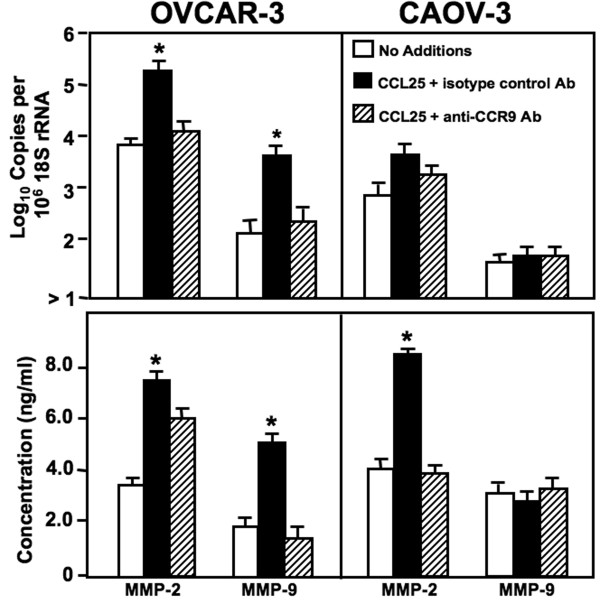
CCL25-induced gelatinase expression by ovarian cancer cells. Cells were tested for their ability to express gelatinases (MMP-2 and MMP-9) mRNA and protein. OVCAR-3 and CAOV-3 cells were cultured for 24 hours alone, with 100 ng/mL of CCL25, or 100 ng/mL of CCL25 + 1 μg/mL of monoclonal antibodies against CCR9. Total RNA was isolated and quantitative RT-PCR analysis was performed for mRNA expression of gelatinases (upper panel) and transcript copies are presented relative to actual copies of 18 S rRNA. Active gelatinases in conditioned media were quantified by Fluorokine and Biotrak assays (lower panel). MMP expression below the detectable limit of the RT-PCR is designated as below detection (BD). Asterisk(s) indicate statistical differences (p < 0.01) between untreated and CCL25-treated OvCa cells.